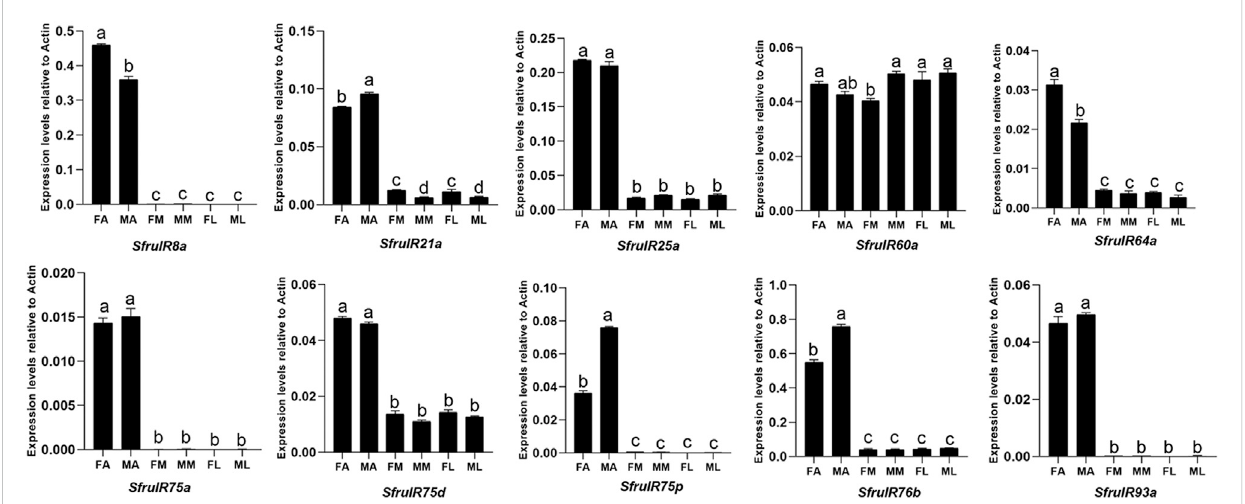
FIGURE 7 Expression patterns of candidate IRs in different chemosensory tissues of adult S. frugiperda . RT-qPCR analysis was conducted for SfruIR genes in femaleantennae(FA),male antennae(MA),femalemouthparts(FM),male mouthparts (MM),femalelegs (FL), andmale legs(ML).Different letters indicate